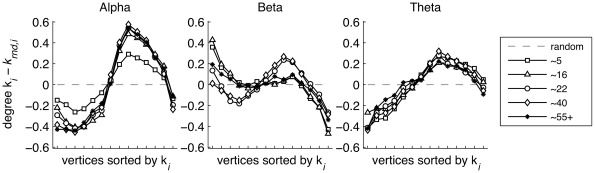
Stability and change in network quality.Sorted degree distributions relative to random graphs for 5 different age groups can be matched to prototypical networks described in figure 1. Alpha oscillation networks (left plot) consistently showed a clustered small-world organization. Childhood ages showed a degree distribution closer to random, but the clustering is clearly visible. Increased age created increased deviation from random but did not qualitatively change the network. Beta networks (right plot) showed a degree distribution close to random for children and adolescents, but since the clustering coefficient was much larger than 1.0 (figure 3), networks in these groups are perhaps best described as a mix between lattice and clustered small-world network. The brain progressed into a clustered small-world network in adulthood (∼22 to ∼50 years) but increased tilt again for the eldest groups (55+) indicating a more lattice small-world network. Theta oscillation networks also showed evidence for a clustered small-world network with a set of nodes with high degree, and a set of nodes with low degree. This pattern was observed throughout life.